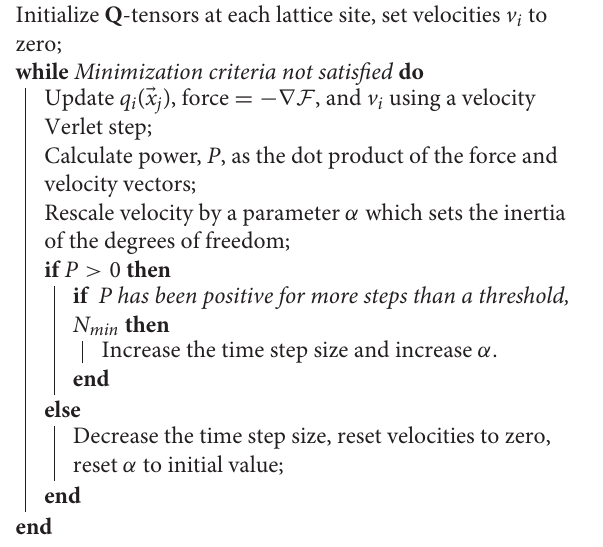
250 3 ), starting from a =